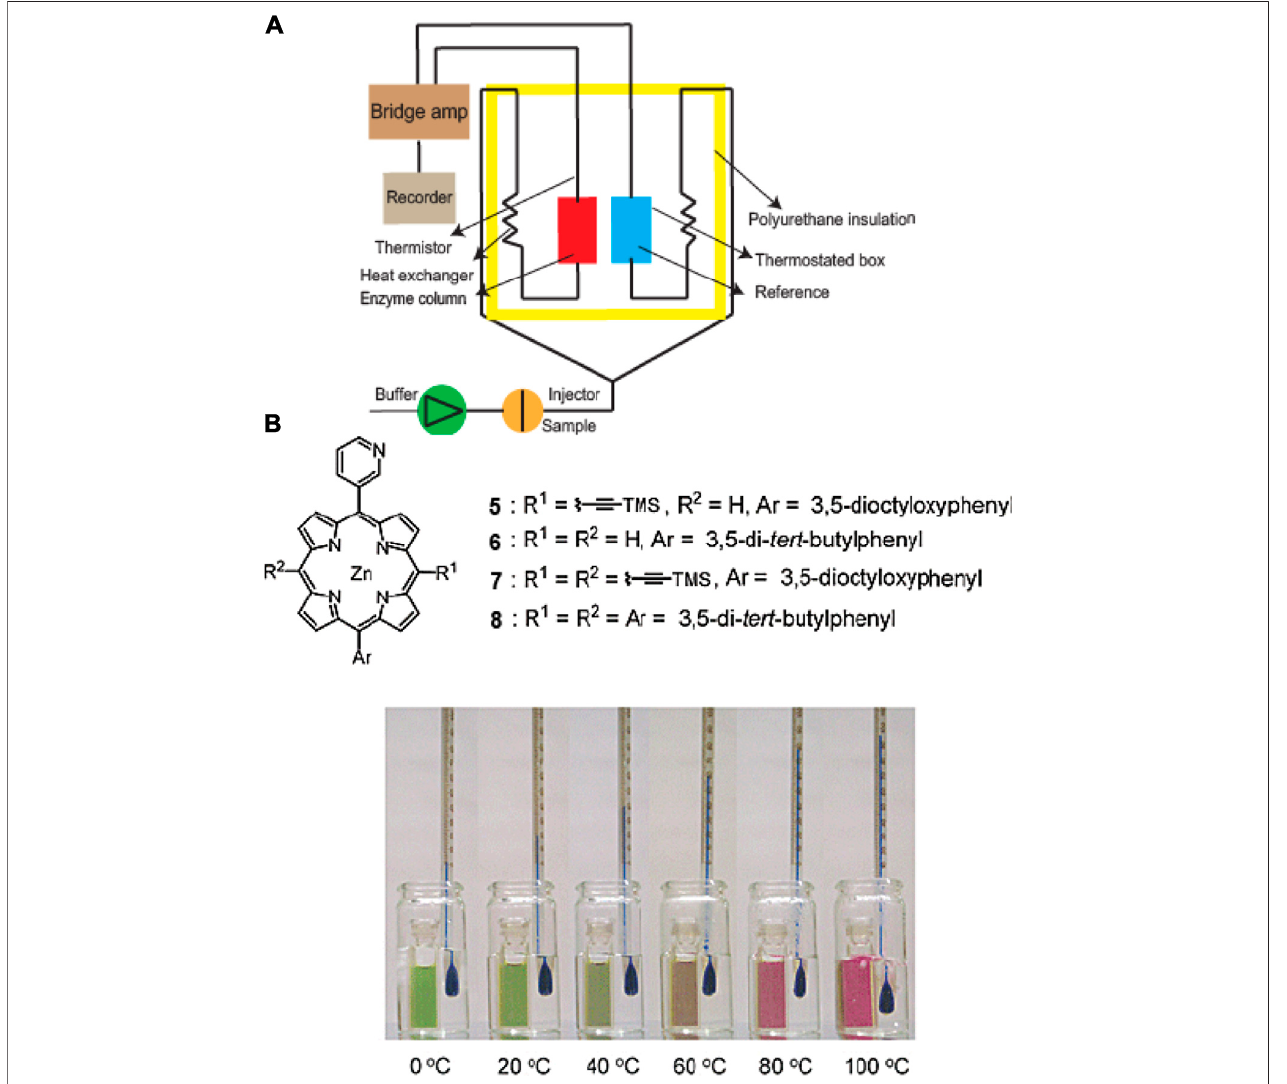
FIGURE 10 | (A) Schematic diagram of a thermal biosensor. (B) Thermochromism exhibited by a zinc complex of alkynyl-functionalized (3-pyridyl)porphyrin in toluene. Adapted from (Tsuda et al., 2003; Zhou et al., 2012). Copyright 2003 American Chemical